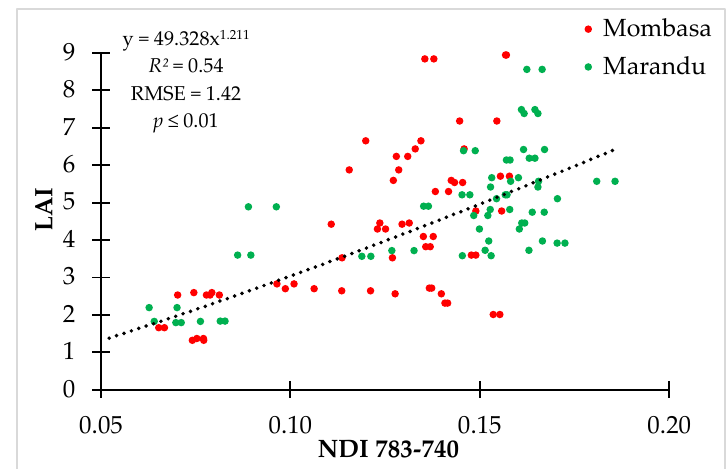
Figure 11. Graph representation of LAI (m 2 m −2 ) as a function of the NDI index in the experimental Marandu and Mombasa study area.